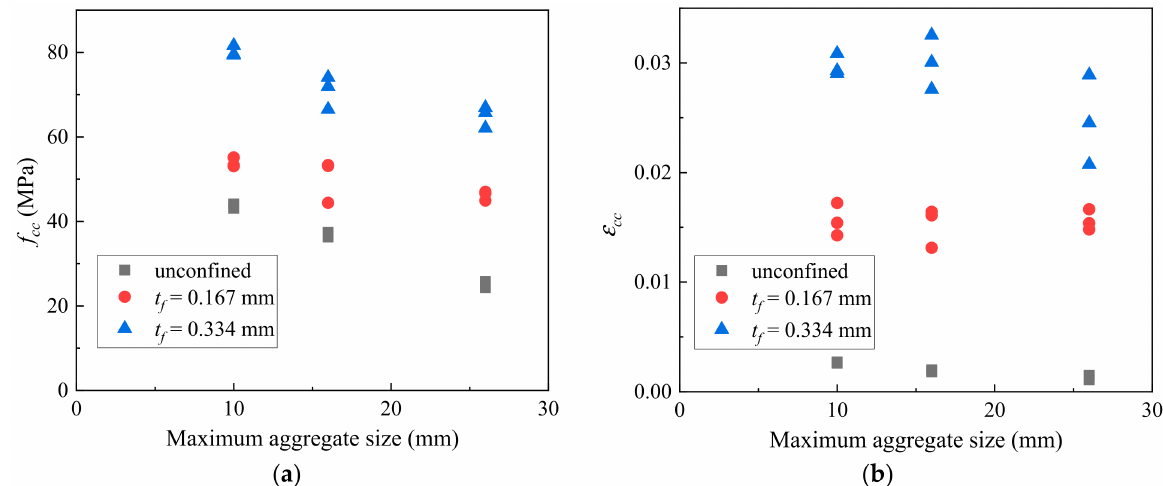
Figure 9. Effect of coral aggregate size on: ( a ) compressive strength; ( b ) ultimate axial